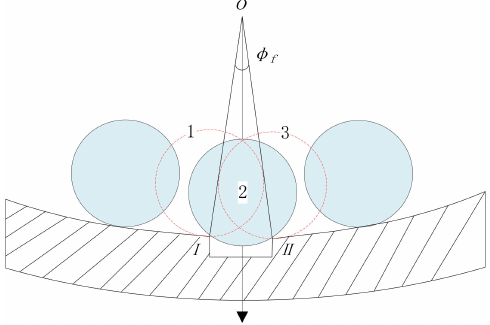
Figure 4. Roller passing defect state